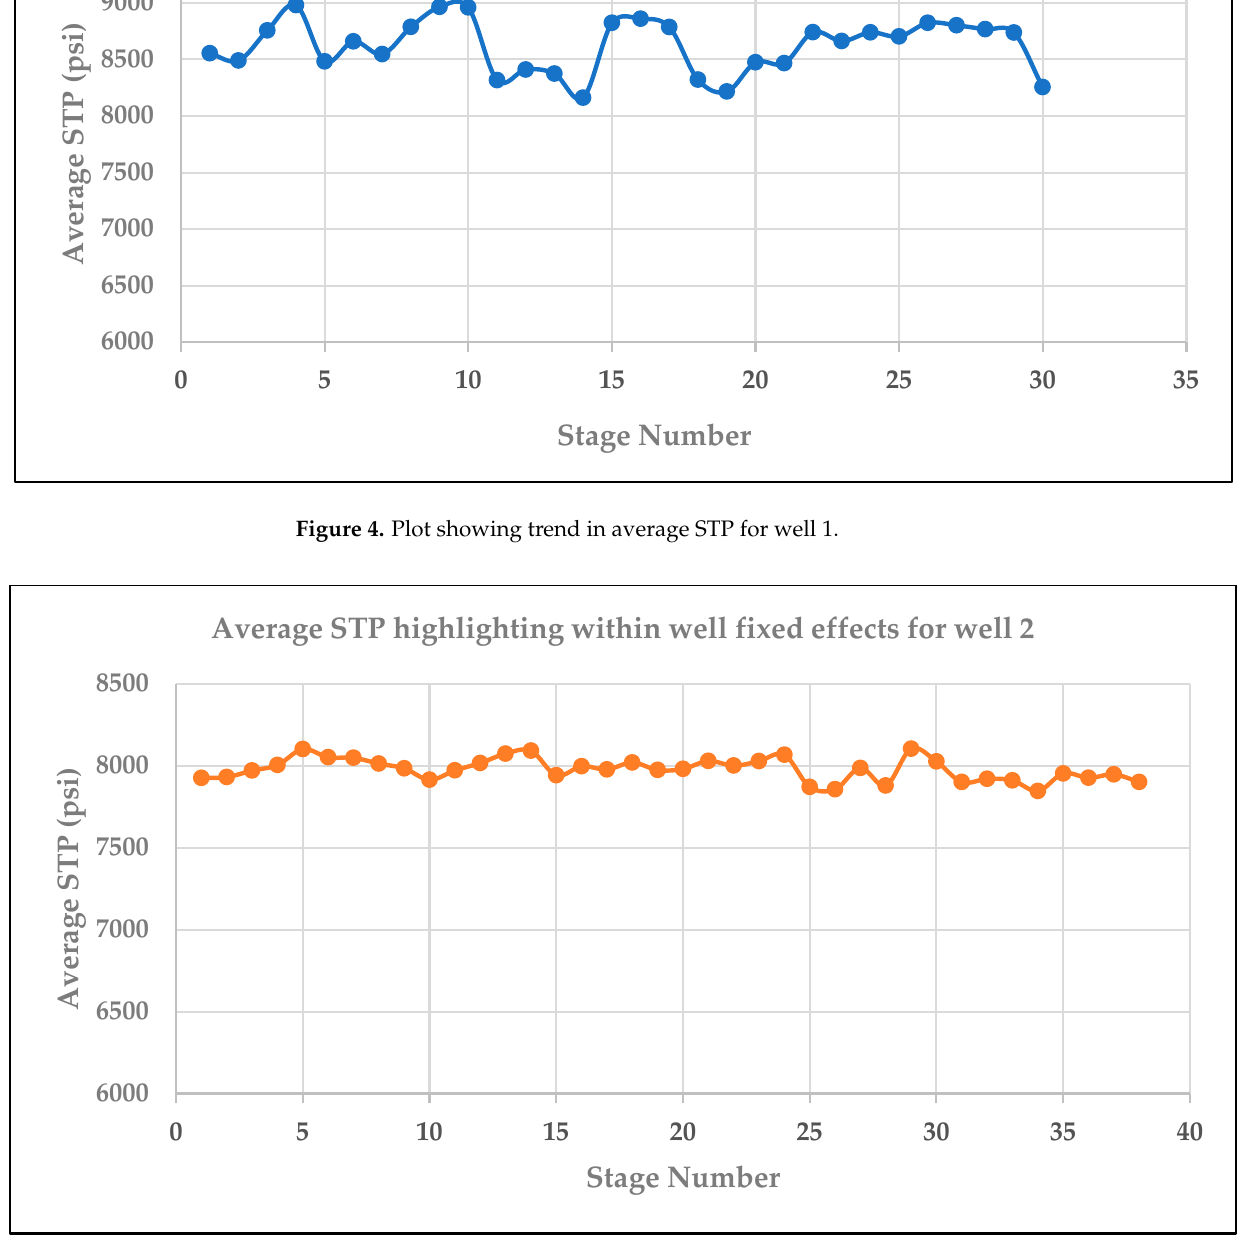
Figure 5. Plot showing trend in average STP for well 2.